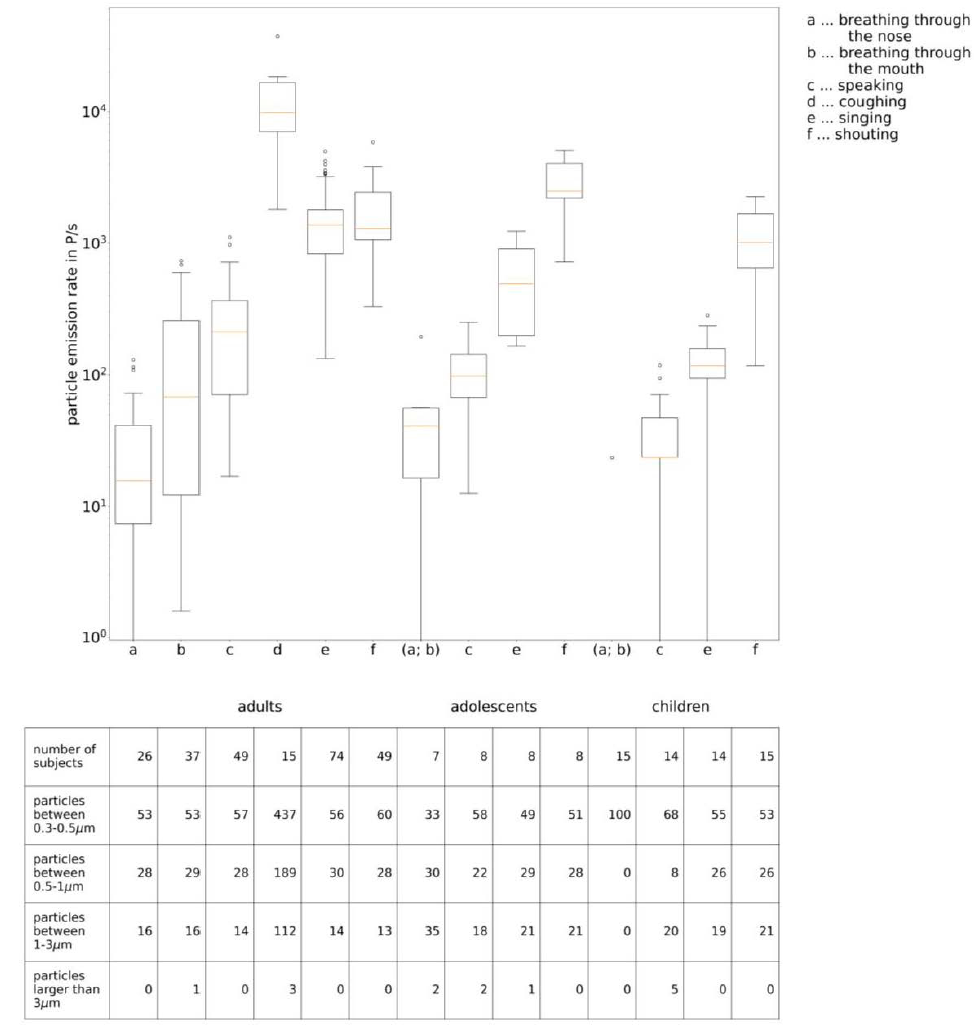
Figure 2. Particle emission rates measured by some of the authors, for adults [35,37,38], for adoles- cents [39] and for children